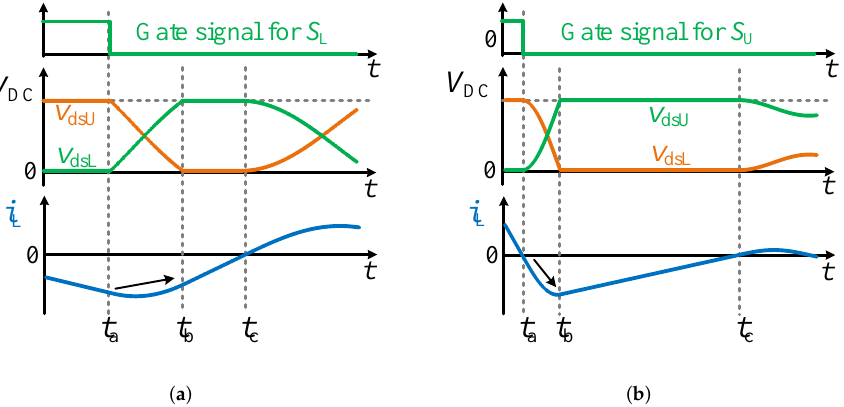
Figure 5. Schematic waveforms of the drain–source voltages and the inductor current with a long enough dead-time period of critical switchings, ( a ) for the condition of E dc > 0, and ( b ) for the condition of E dc <